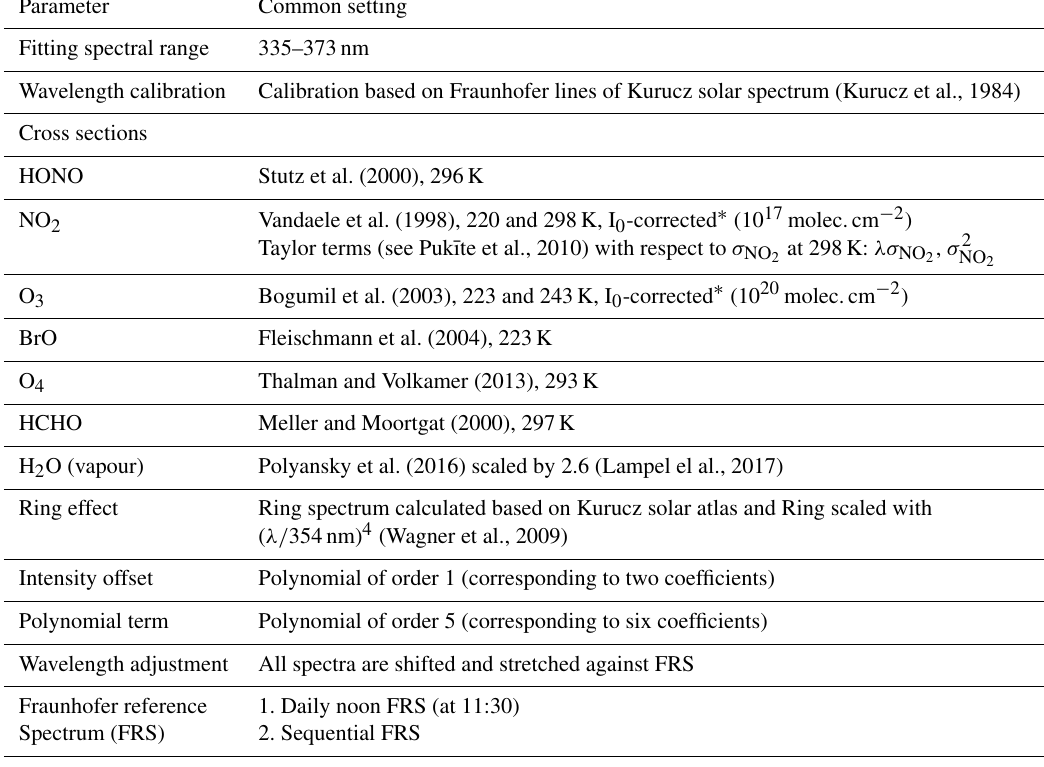
Table 2. Baseline DOAS analysis settings for the HONO fit.